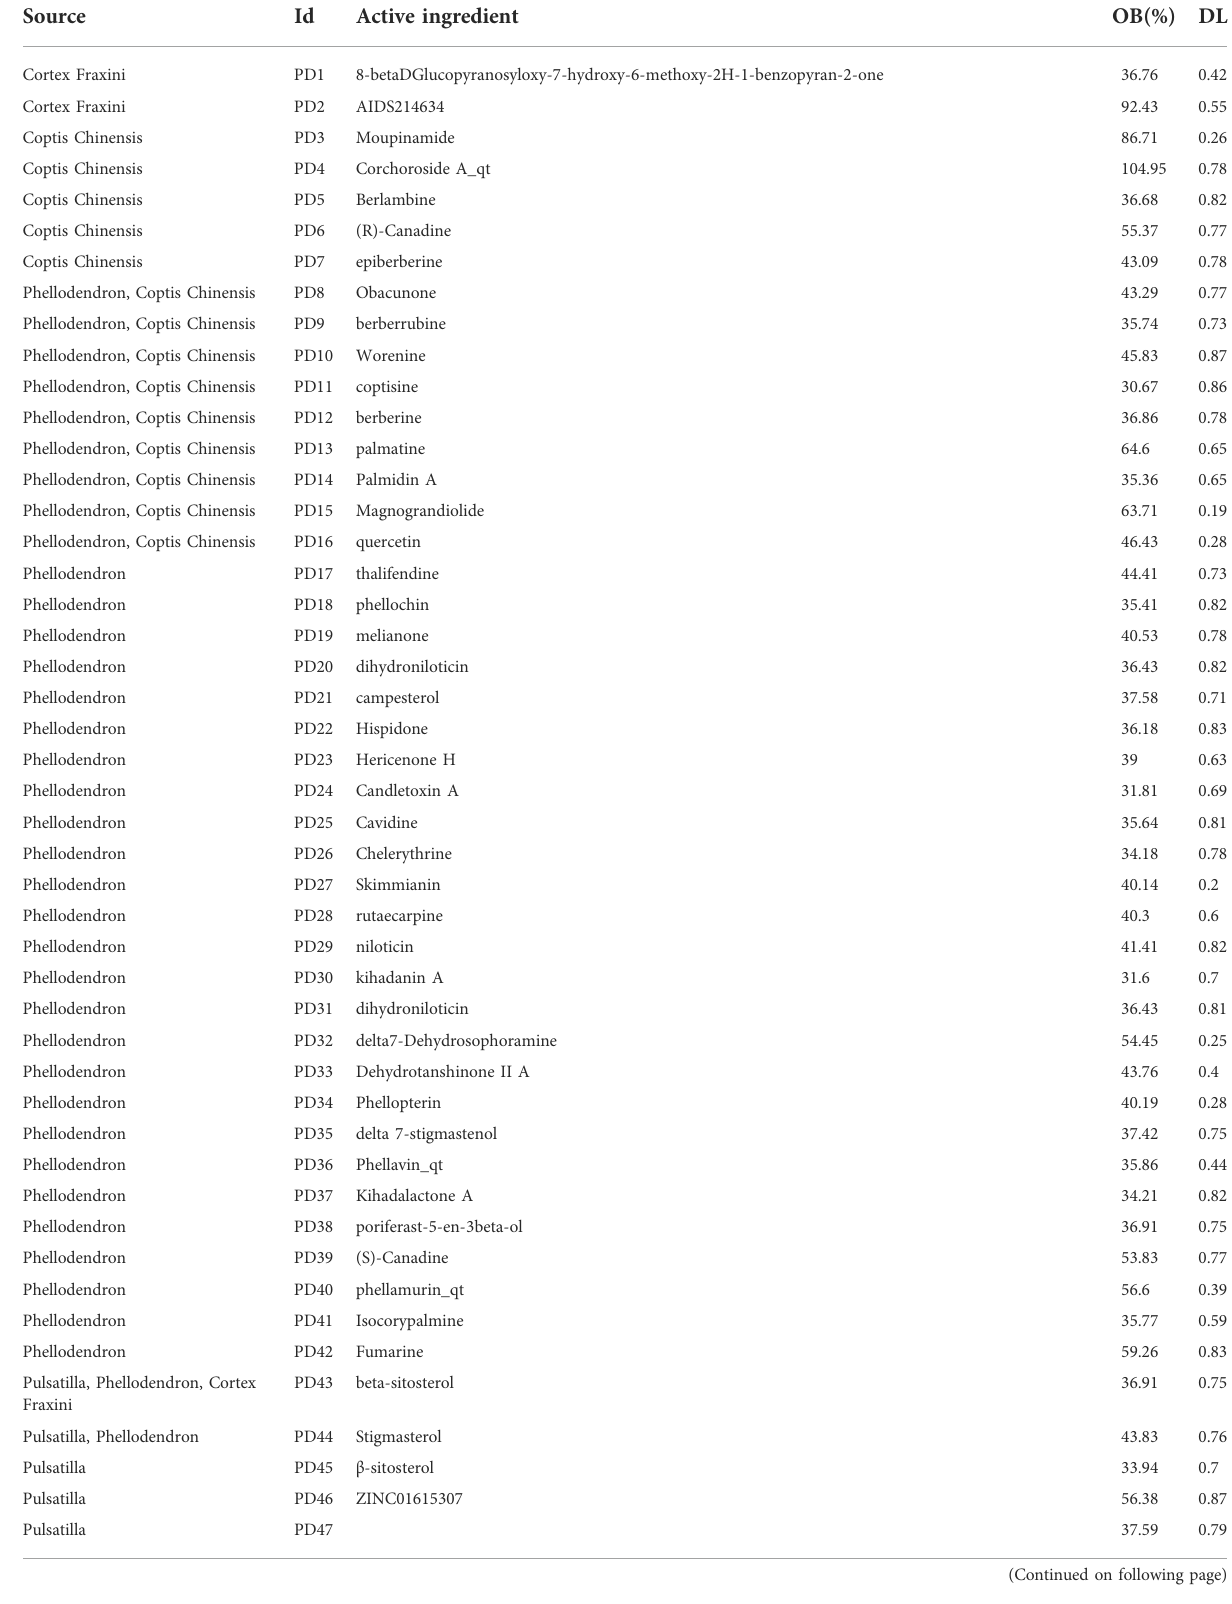
TABLE 1 Basic information of active components of